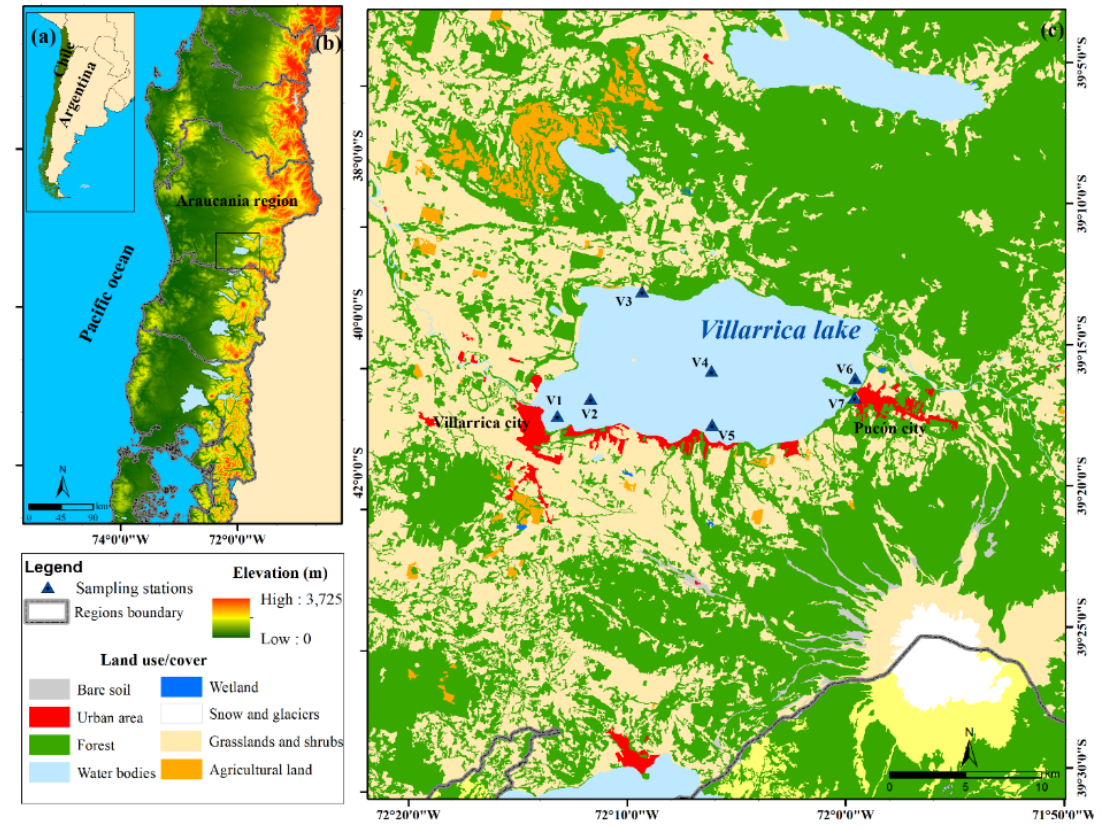
Figure 6. ( a ) Chile in South America; ( b ) Araucan í a Region with topographic profiles, with the study area, including Lake Villarrica, outlined in black; and ( c ) the land uses of the Villarrica